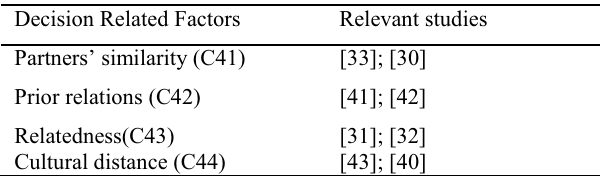
Table 3: Decision related